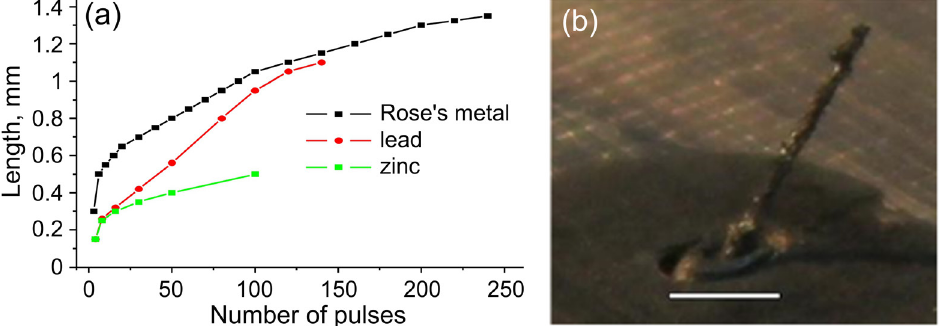
Figure 9. ( a ) Microtower length as a function of number of laser pulses for three metals.